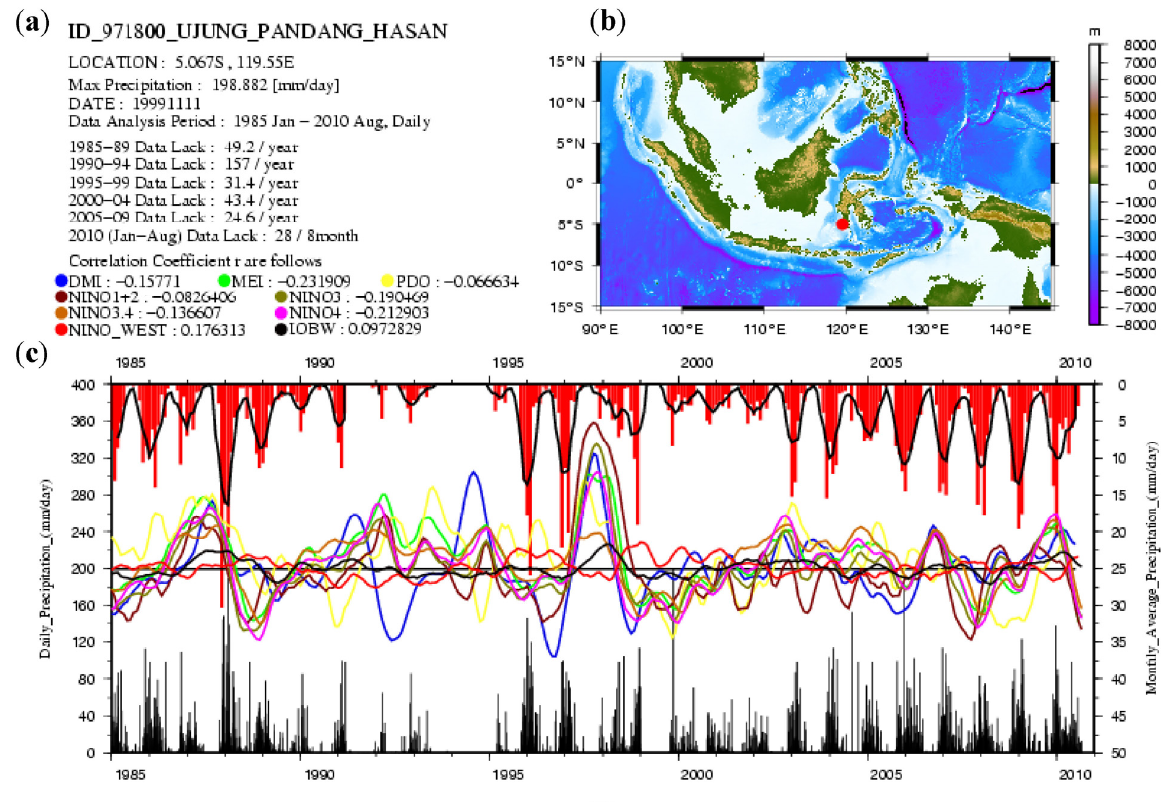
Figure 4. ( a ) Summary of the Ujung Pandang Hasan station located in southern Sulawesi.